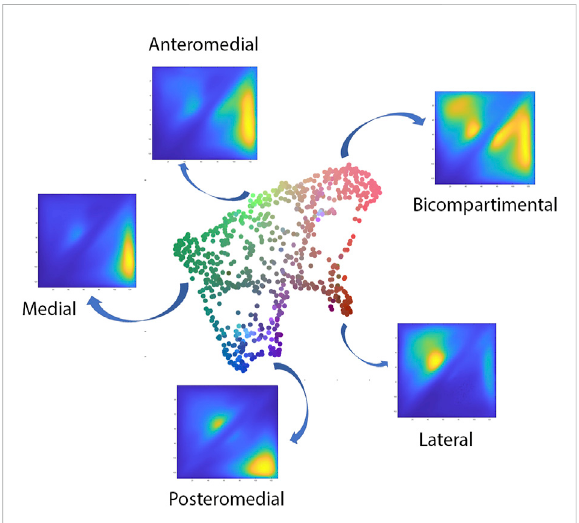
FIGURE 6 Visual representation of the projected shape space of OA cases with RGB coloring according to the observed value of the fi rst three principal polynomial